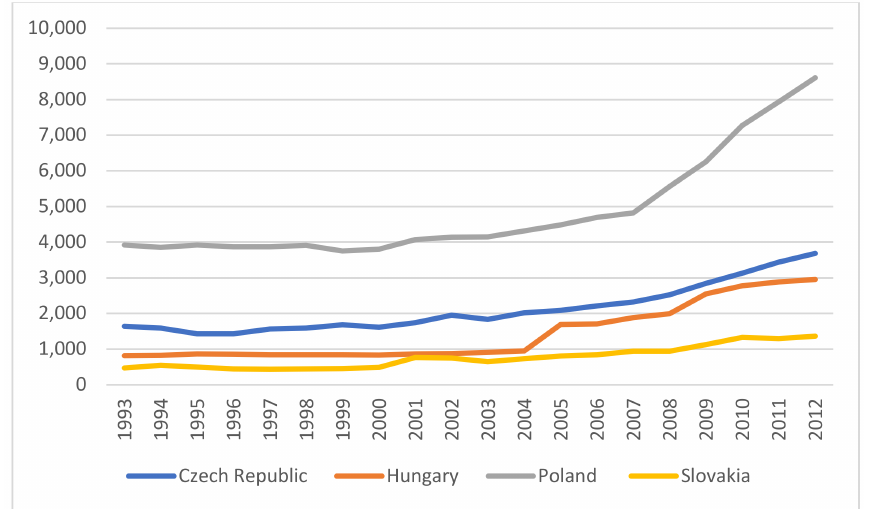
Figure 1. Production of renewable energy (in thousand tons of oil